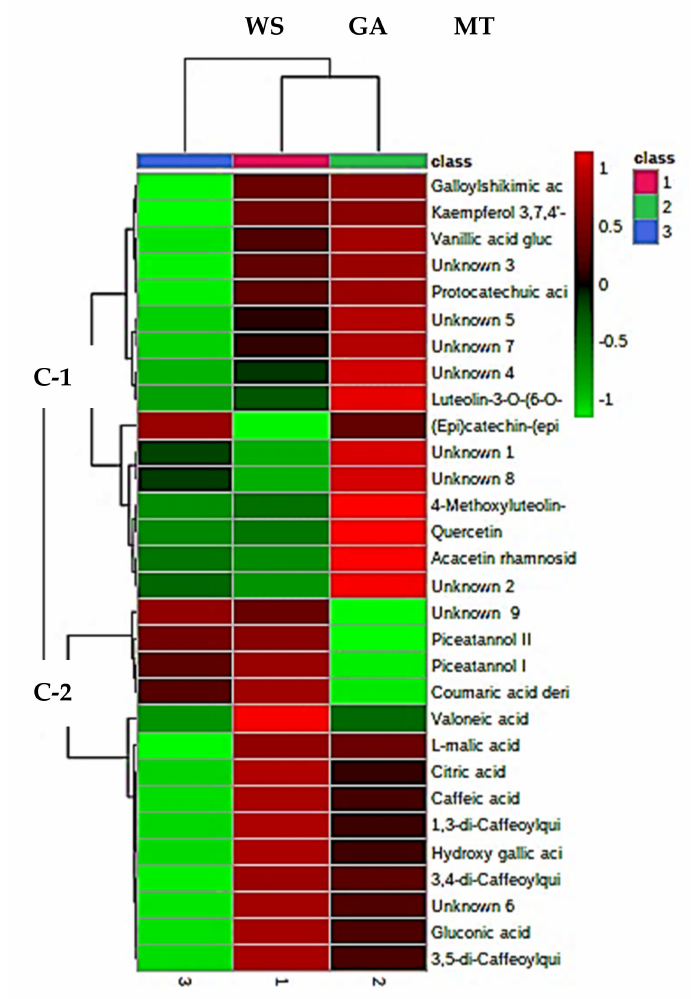
Figure 6. Heat map illustrating the relative concentrations of the identified compounds from the freeze-dried passion fruit peel powders developed using different carriers. The red boxes indicate relatively higher mean concentrations, while the green boxes indicate lower concentrations among the powders. GA = gum arabic, MT = maltodextrin, WS = waxy